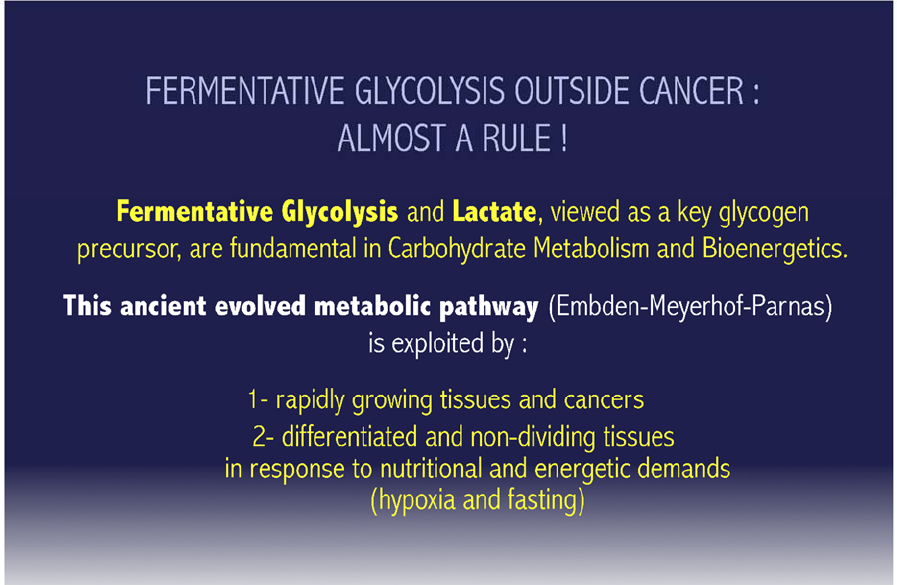
Figure 2. Key conclusions issued from the analysis of fermentative glycolysis (Warburg effect) in normal tissues and cancers [51].